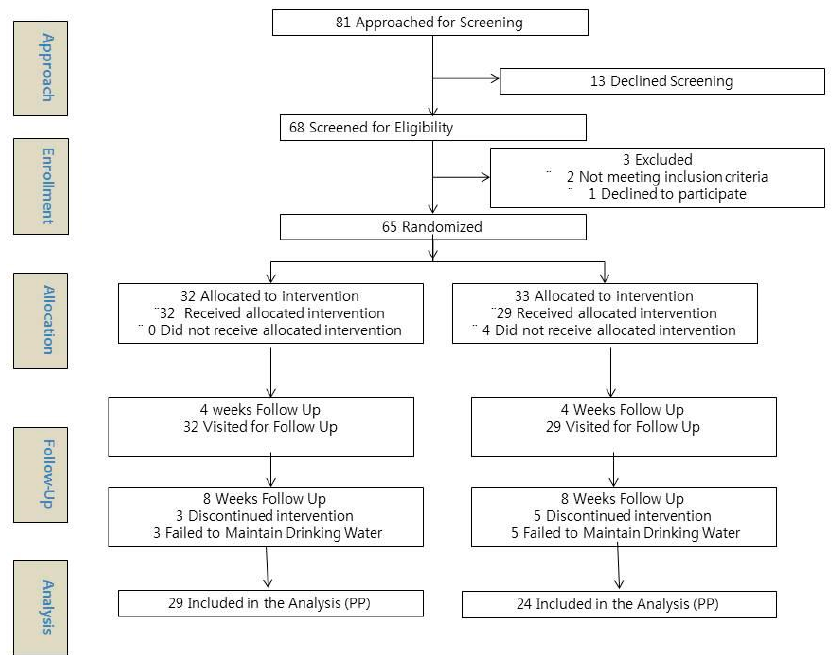
Figure 1. A Consolidated Standards of Reporting Trials (CONSORT) flow diagram.(corrected in the separate files)